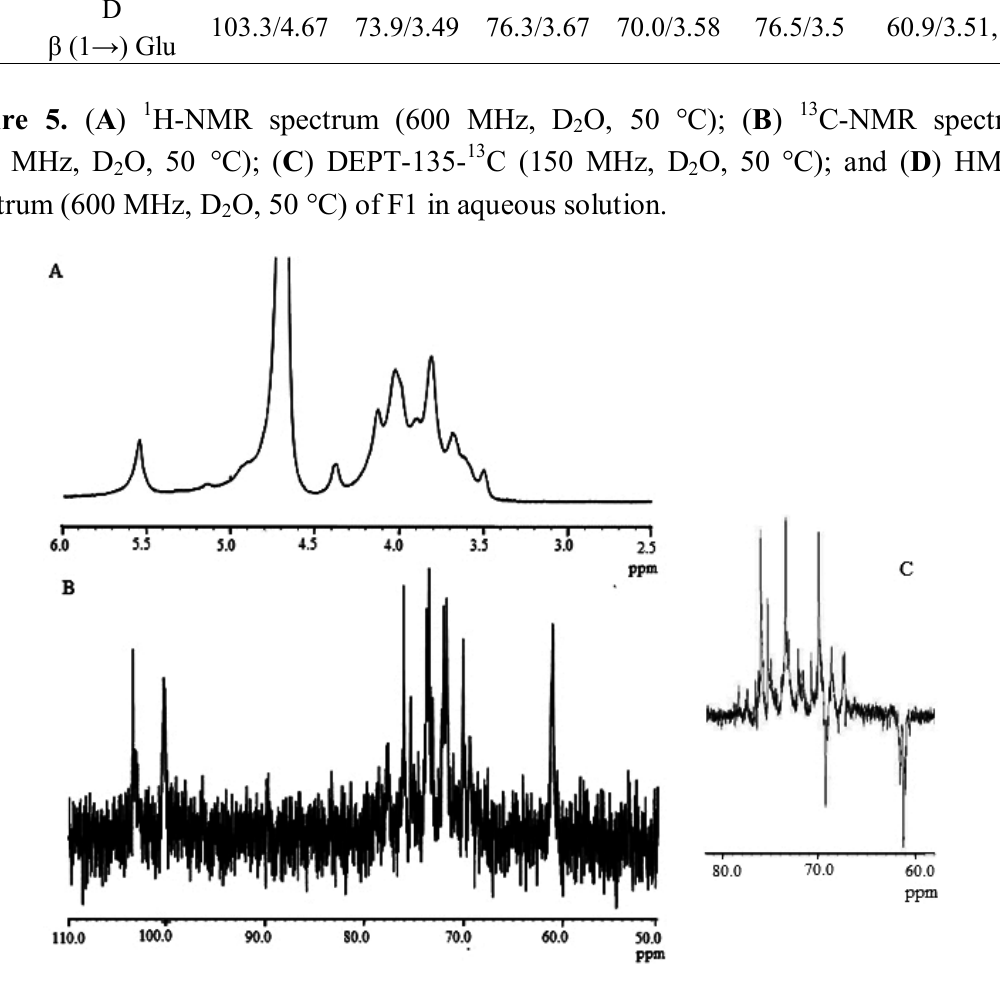
O, 50 °C); ( B ) 13 C-NMR spectrum 2 O, 50 °C); and ( D ) HMQC 2